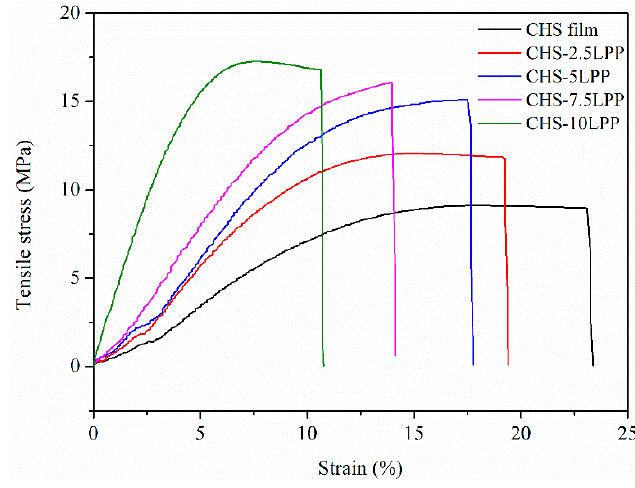
Figure 6. Stress-strain curves of the films.